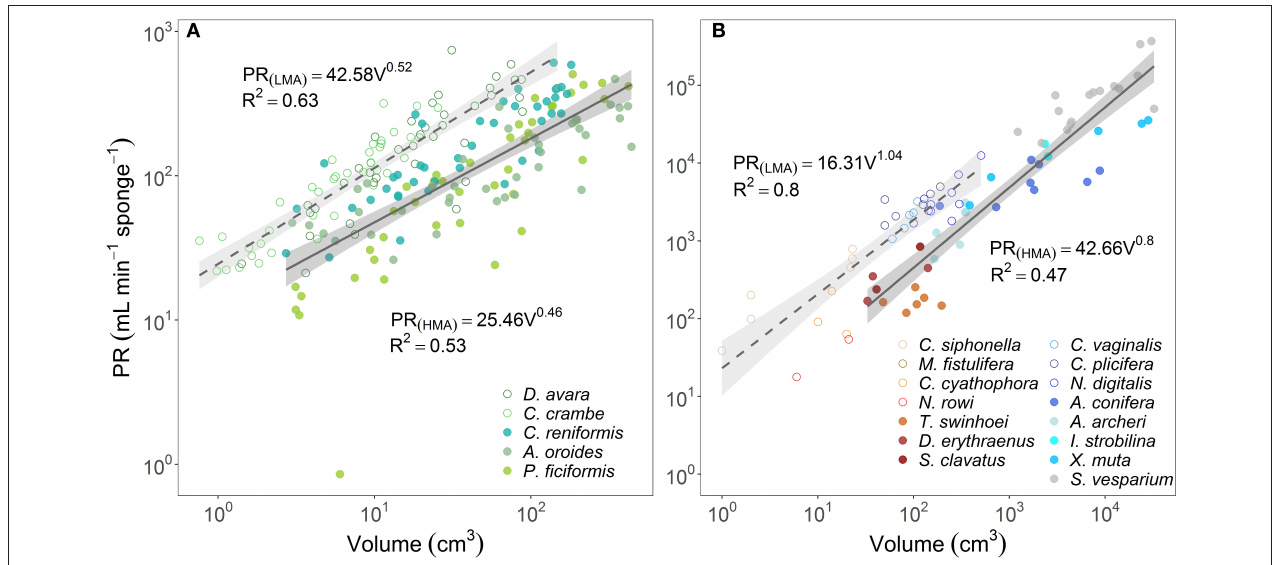
FIGURE 4 | The relationship between the pumping rate (PR, mL min − 1 sponge − 1 ) and the sponge volume (V, cm 3 ) are plotted using log scale in (A) the Mediterranean species and (B) tropical species from Red Sea (reddish color shades) and Caribbean Sea (blue color shades). For the regression analysis, sponges species were clustered accordingly to host type: HMA (closed symbols, solid regression lines) and LMA (empty symbols, dashed regression lines). The scaling exponents and coefficients calculated for HMA and LMA separately are shown in each panel and the shade areas represent the 95% confidence interval for the regression line. The b scaling exponents were statistically different from zero for all equations ( p < 0.001). The scaling exponents and coefficients calculated separately for each Mediterranean species are shown in Supplementary Table 3B . Note different log-log scale between the two panels. TABLE 1 | Testing the utility of different sponge parameters as predictors of sponge pumping rate in the five sponge species from the Mediterranean Sea. Species V A P OSA #oscula + average OSA